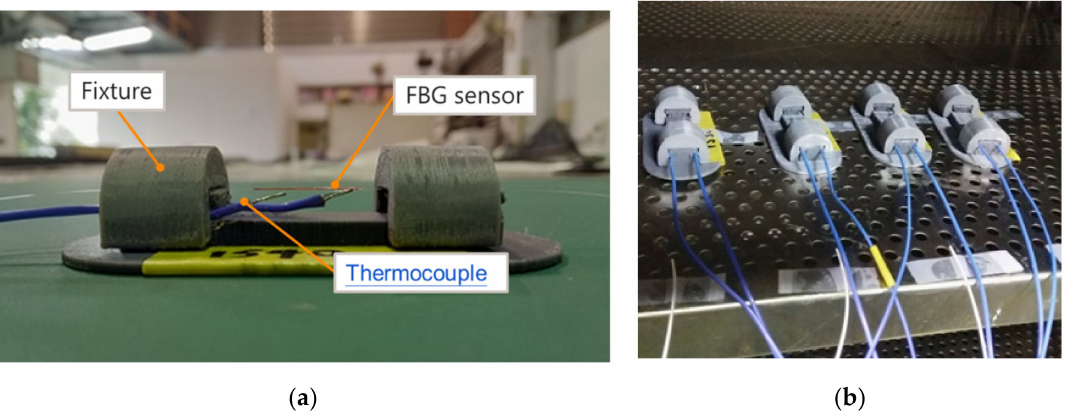
Figure 3. FBG and thermocouple sensor. ( a ) Fixing method of FBG sensor and thermocouple. ( b ) Schematic diagram of heating